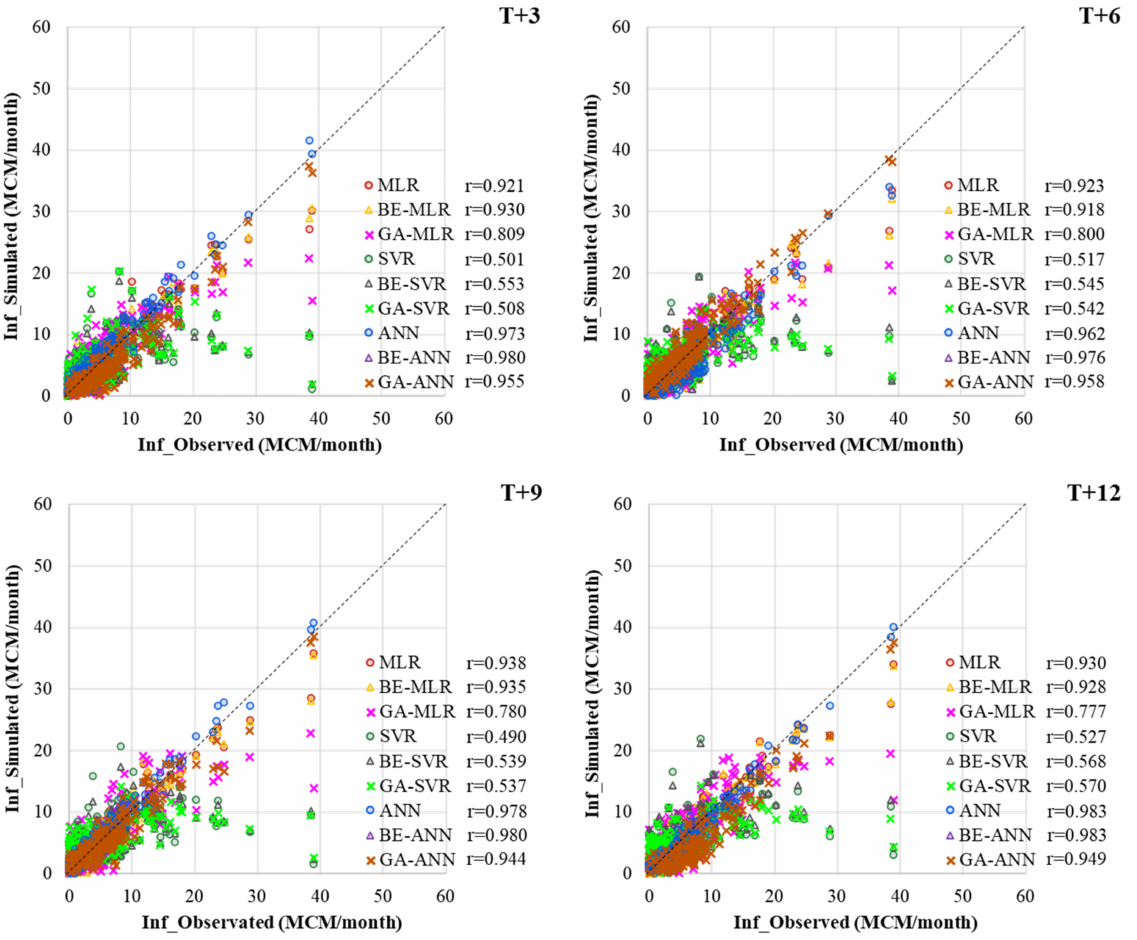
Figure 6. Scatter plot between observed and simulated reservoir inflow of nine machine learning techniques for four lead